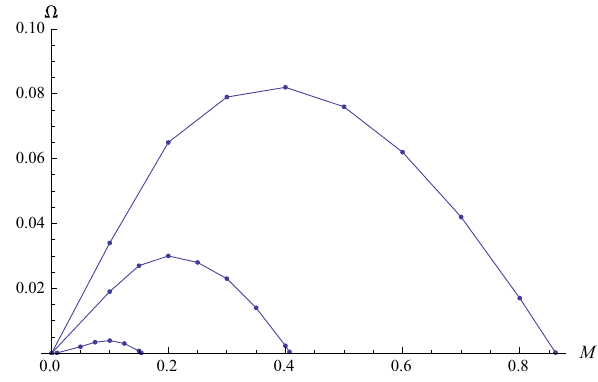
Fig. 1 Plots of mass M for a massive spin-2 as a function of b with l = 10 and κ = 1 in the linearized Einstein-Weyl gravity. The M = 0 ( b = b ∗ ) casecorrespondstothecriticalgravity,whilethreehorizontal lines denote M c = O ( 1 )/ r 0 | r + = 1 , 2 , 4 = 0 . 84 , 0 . 40 , 0 . 18